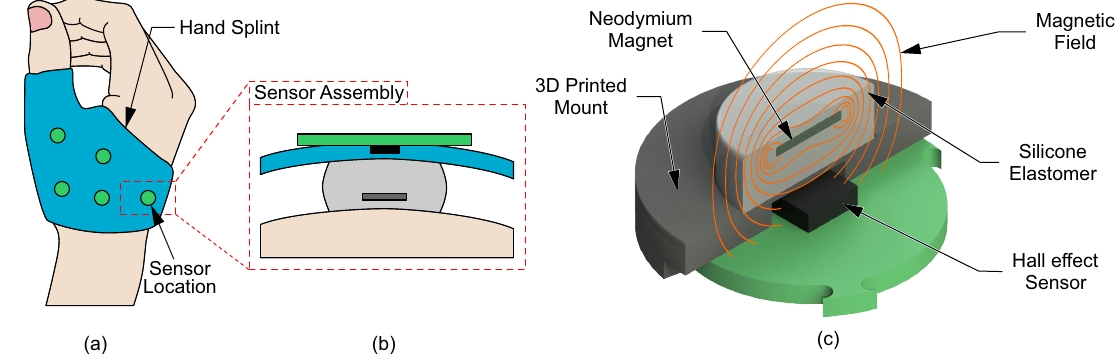
Figure 1. ( a )The sensorised splint concept, ( b ) Placement of the sensor in the proposed splinting method, and ( c ) Components of the soft Hall effect tactile sensor: A neodymium magnet, silicone elastomer, and a three-axis Hall effect